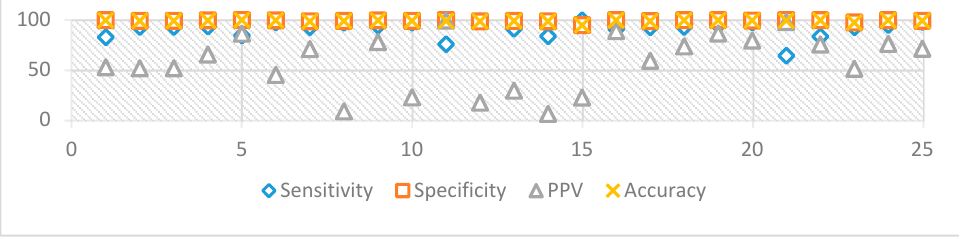
Figure 16. Performance of the algorithm of the 25 images from DIARETDB0/1. Table 4. Comparative results with state-of-the-art testing.